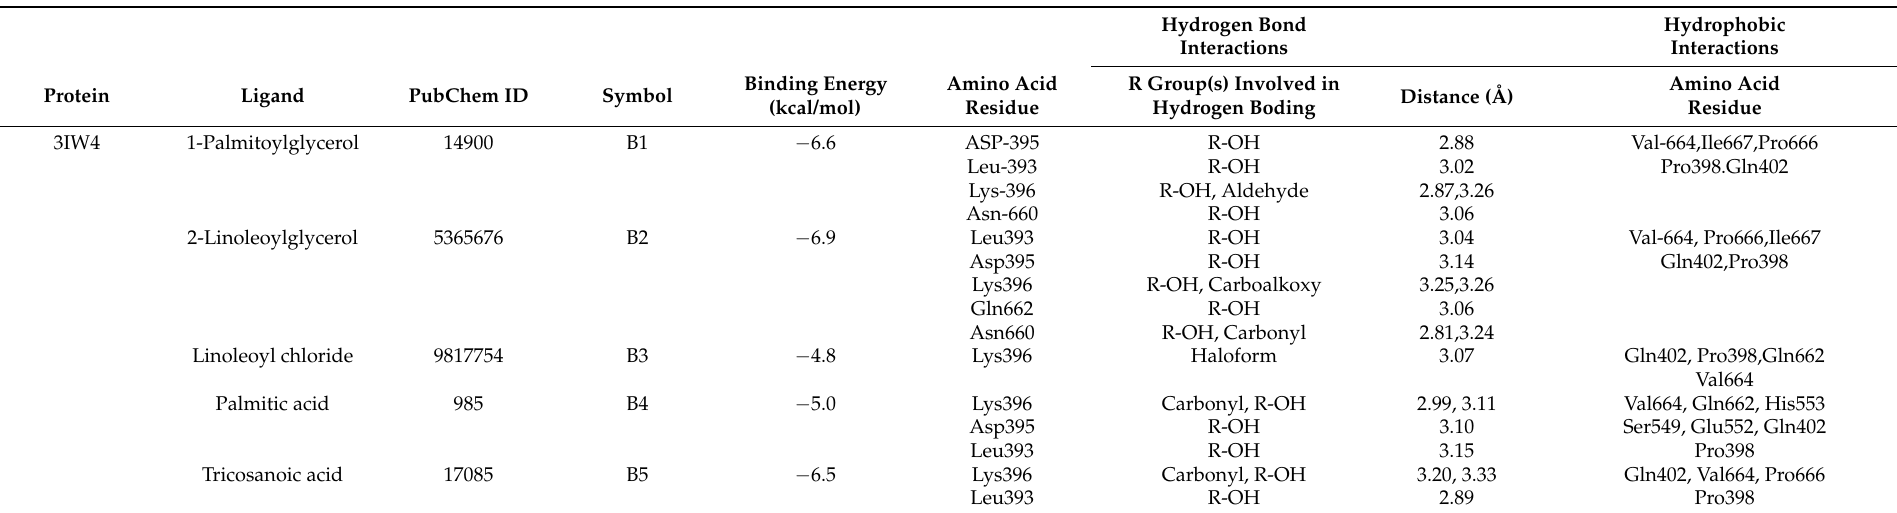
Table 6. Binding energy and interactions of potential bioactives on PRKCA (PDB ID: